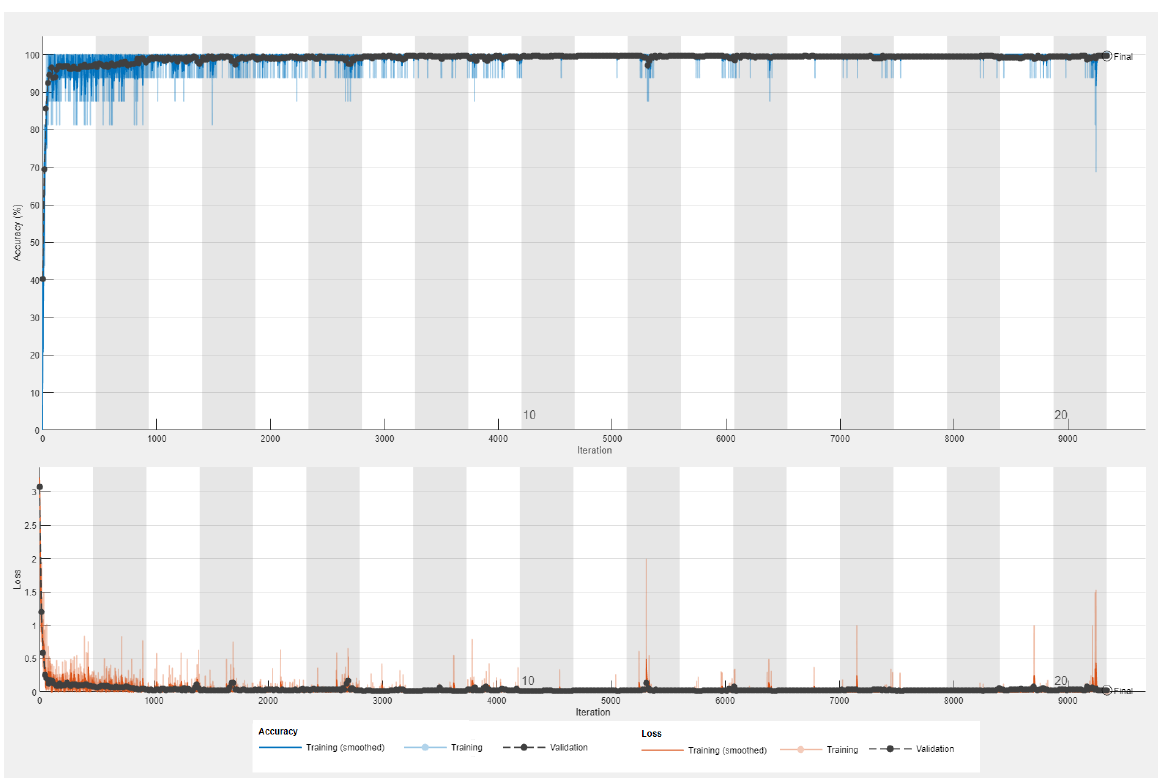
Figure 5. Accuracy and loss curves for the fine-tuned VGG16 classification